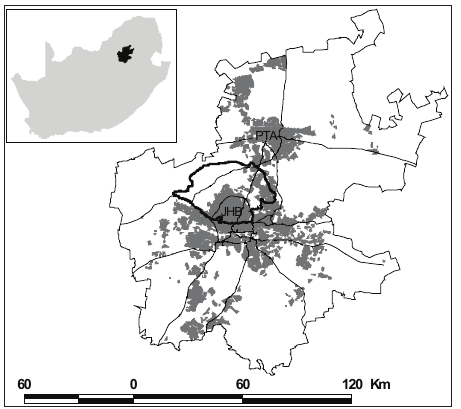
Fig. 1. Locality map of the Egoli Granite Grassland. Grey areas indicate urbanisation